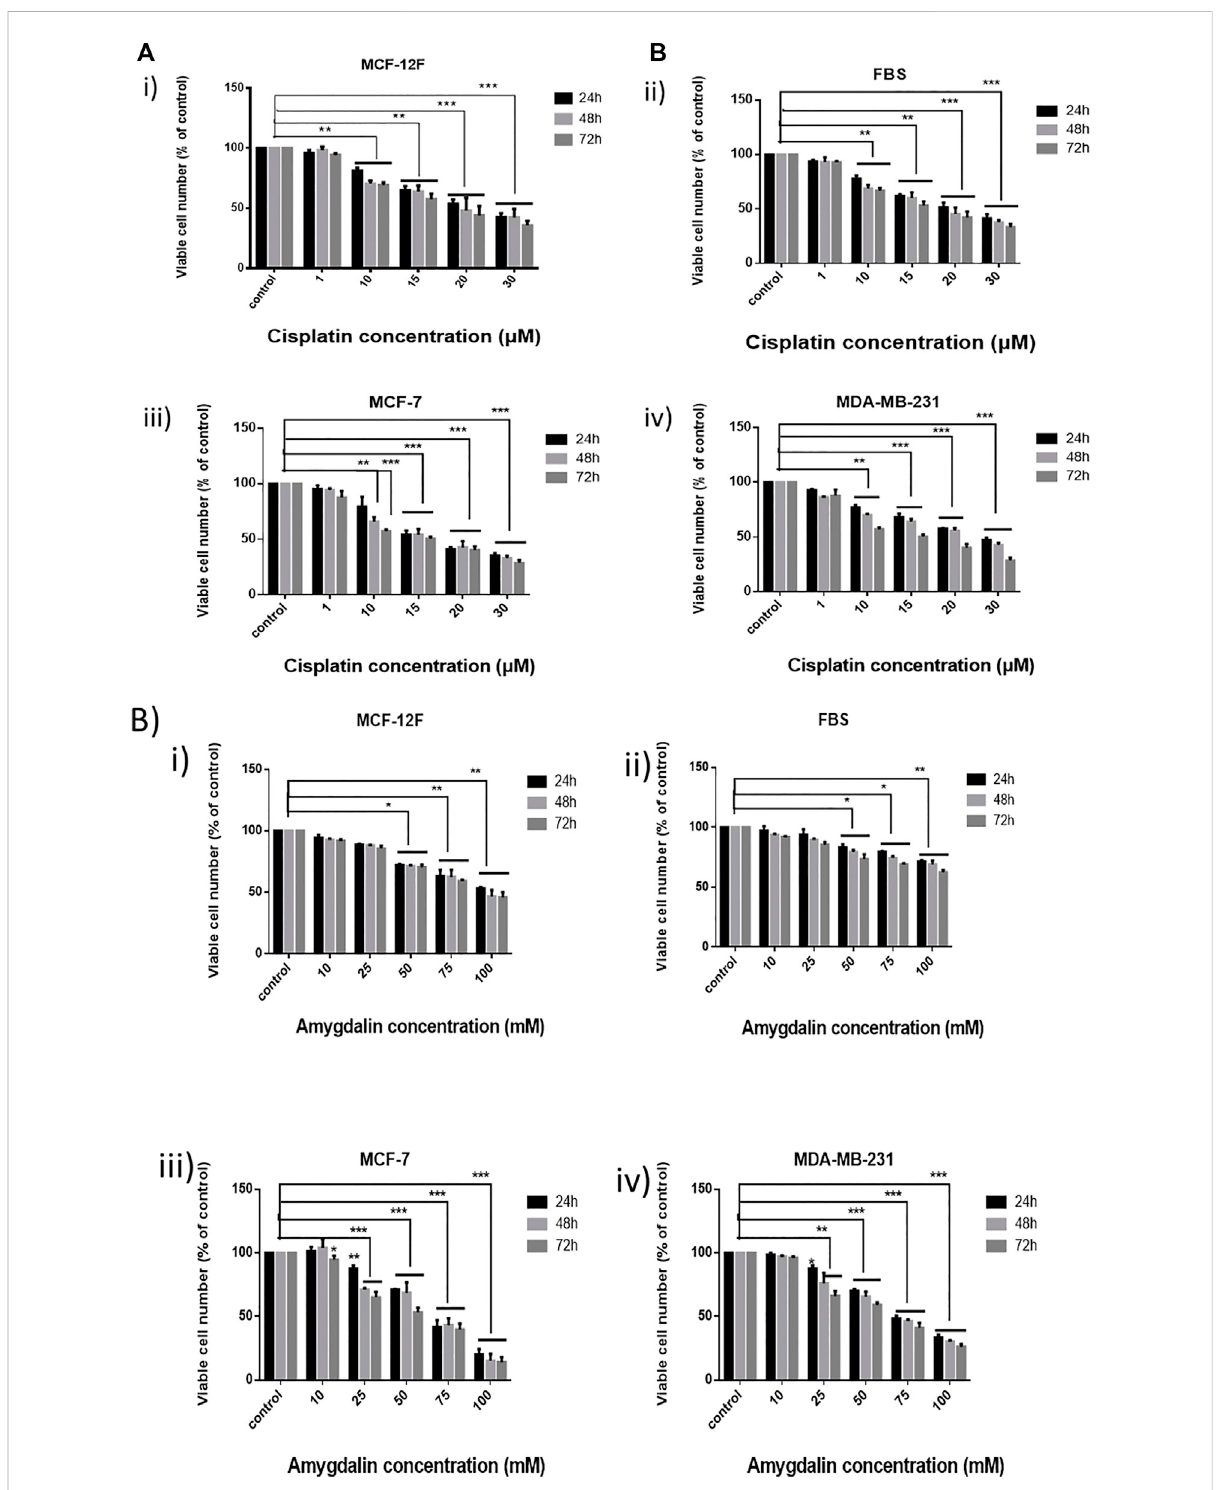
FIGURE 1 Effect of cisplatin and amygdalin in breast cell lines as well as in fi broblasts. (A) MTT assay was employed for the cytotoxicity evaluation (% cell viability) of increasing concentrations of cisplatin (1, 10, 15, 20, and 30 μ M) in i) MCF-12F, ii) FBS, iii) MCF-7, and iv) MDA-MB-231 for 24, 48, 72 h and (B) the increasing concentrations of amygdalin (10, 25, 50, 75, and 100 mM) in i) MCF-12F, ii) FBS, iii) MCF-7, and iv) MDA-MB-231 for 24, 48, 72 h treatment. The asterisks indicate the strength of statistical signi fi cance between bars [* (0.05) < ** (0.01) <